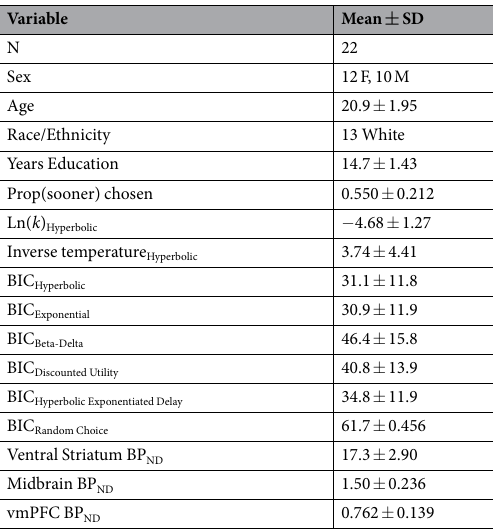
Table 1. Study sample characteristics. Ln( k ) = steepness of discounting slope; Inverse temperature = choice stochasticity; BP ND = non-displaceable binding potential (measure of receptor availability); BIC = Bayesian information criterion (lower values indicate better model fit to the